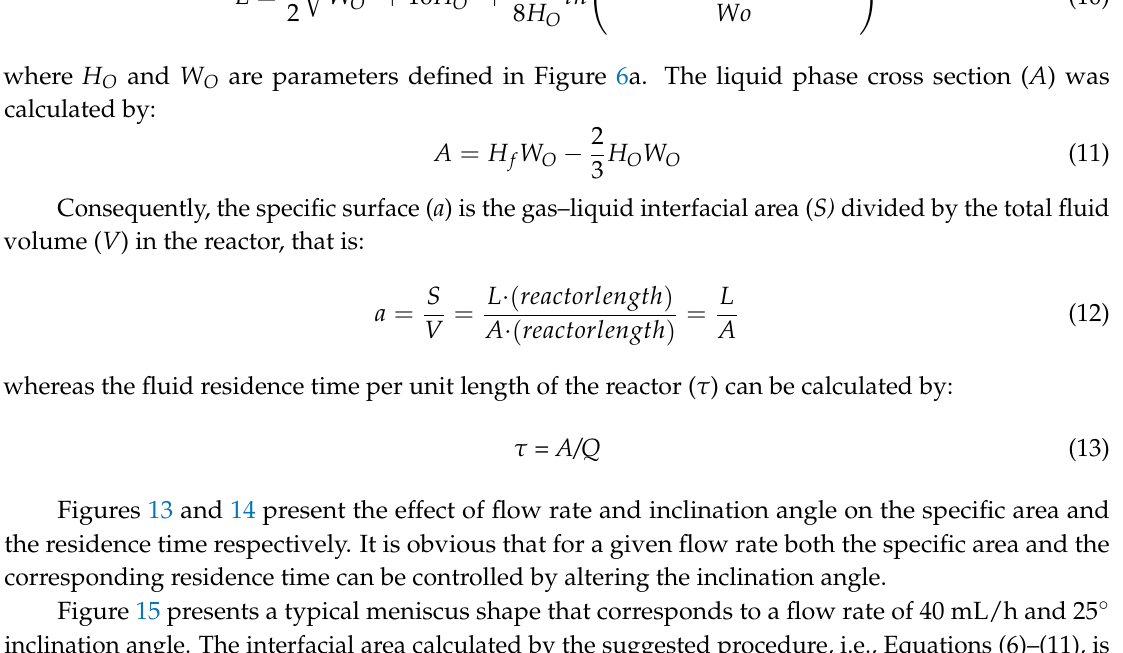
Figure 12. Comparison of experimental data with curves calculated using asymptotic and effective viscosity (nW, 40 mL/h, 25°).